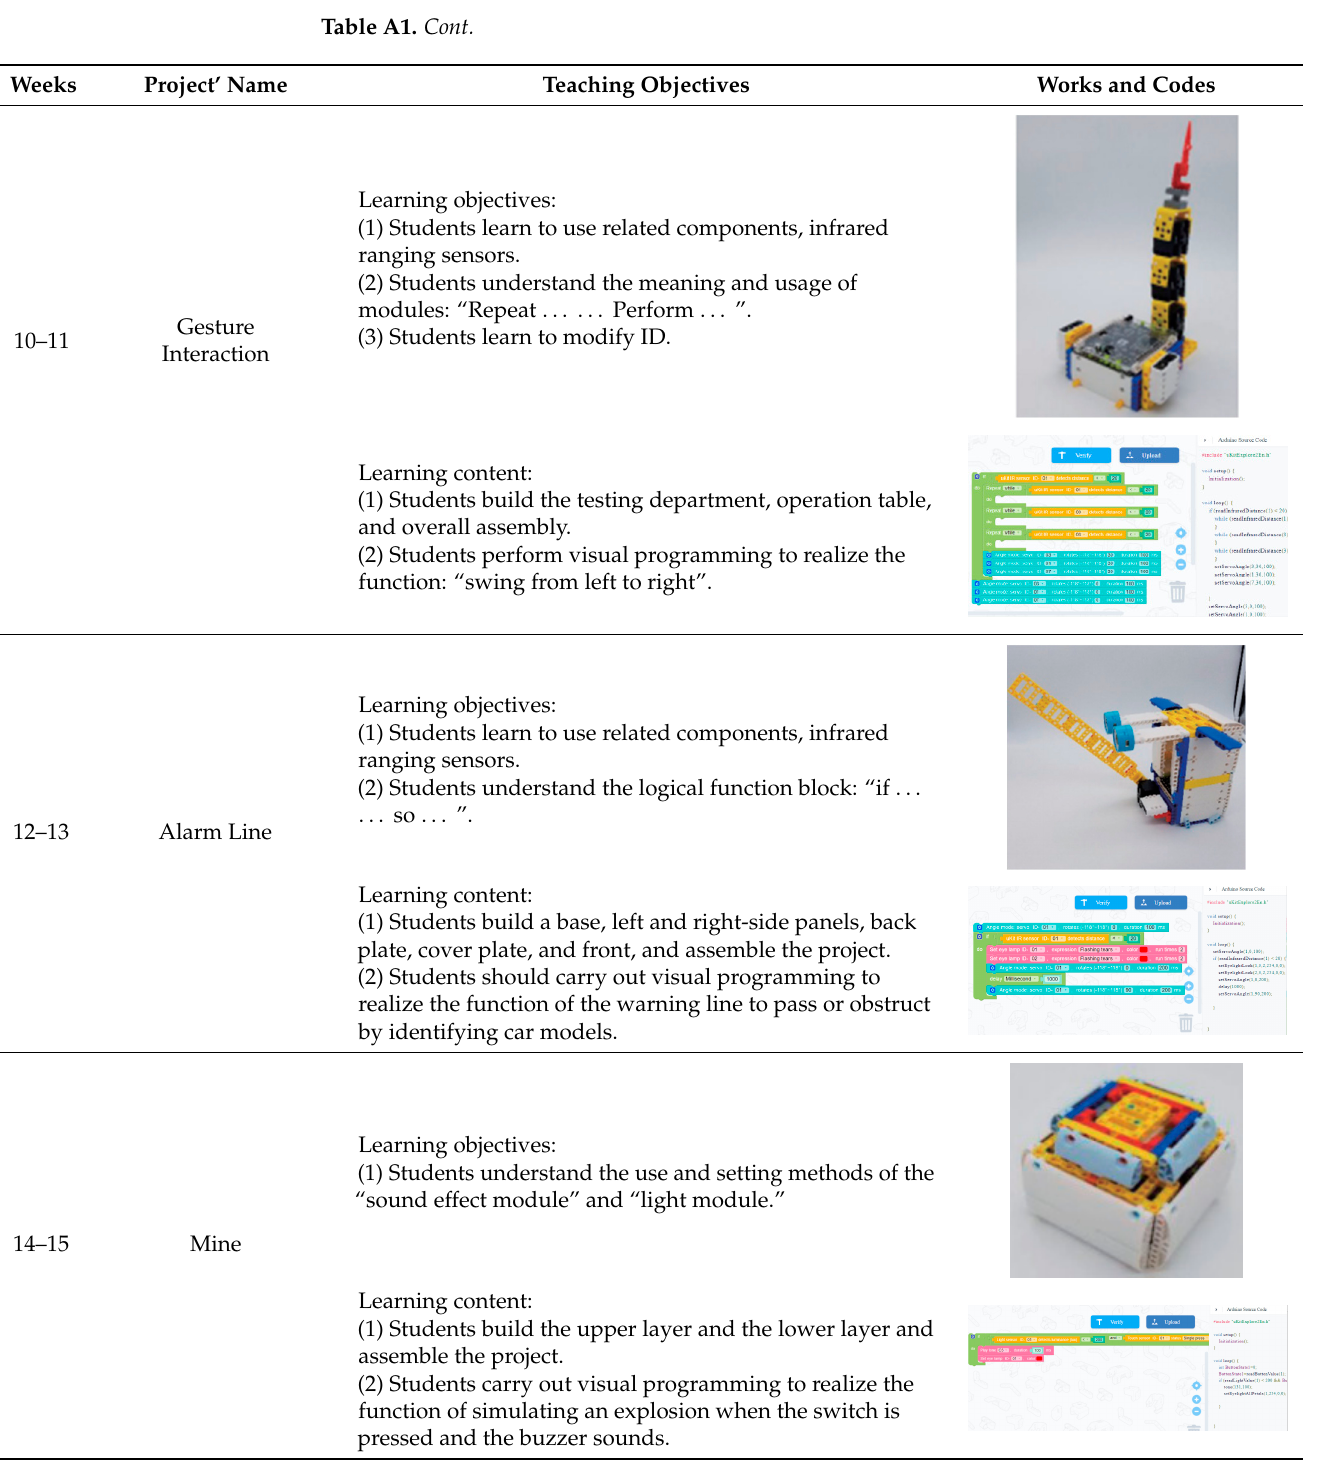
Table A2. Information on the experimental group’s six items.